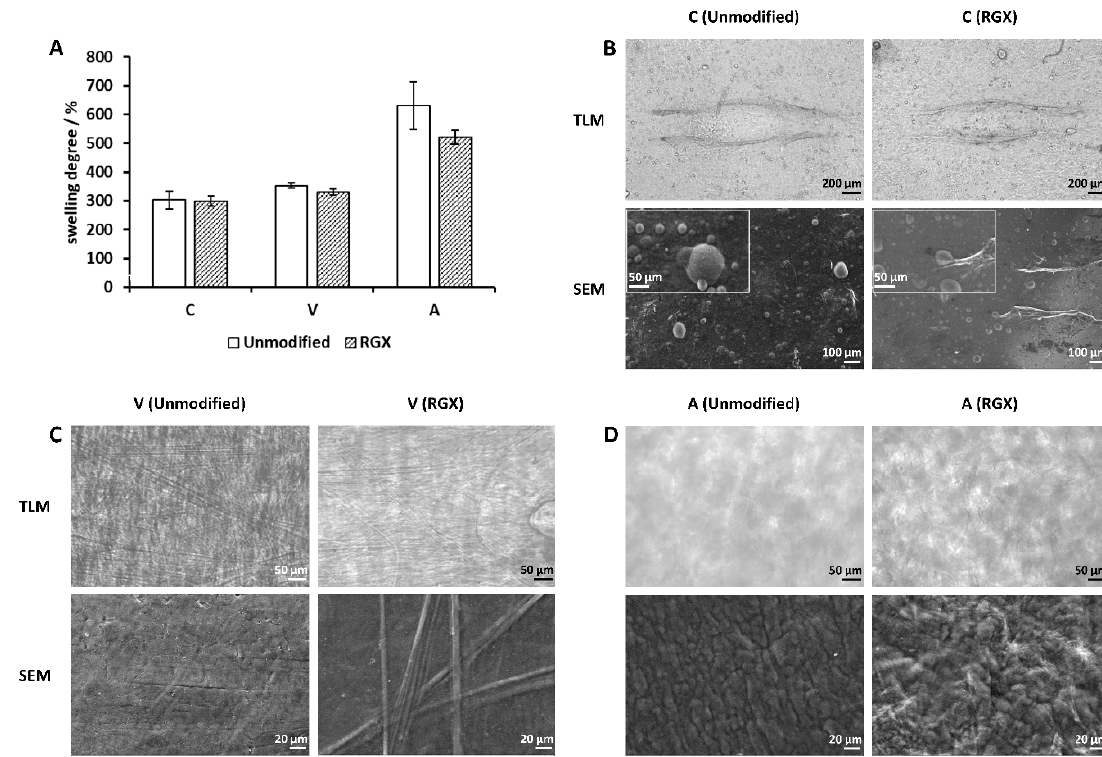
Figure 4. Impact of rose bengal and green light collagen crosslinking (RGX) on swelling degree and microstructure. ( A ) Swelling degree of unmodified and modified (RGX: 10 min, 0.01% rose bengal (RB)) collagen sheets after 2 h at 37 ◦ C in relation to their dry weight (100%). ( B – D ) TLM and SEM images of collagen sheets before (unmodified) and after RGX (10 min, 0.01% RB). Samples analyzed via TLM were conditioned in PBS. ( B ) Collagen Solutions. TLM magnification: 50 × . SEM magnification: 200 × and 1000 × (inset). ( C ) Viscofan. TLM magnification: 200 × . SEM magnification: 1000 × . ( D ) Atelocollagen. TLM magnification: 200 × . SEM magnification: 1000 × ; C: Collagen Solutions, V: Viscofan and A: Atelocollagen.